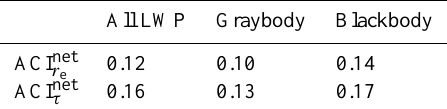
Table 3. ACI net parameter calculated for the optical depth and the effective radius considering all clouds, graybody clouds, and black- body clouds, averaged from values presented in Fig. 5 and weighted considering the inverse of the uncertainty in the mean.